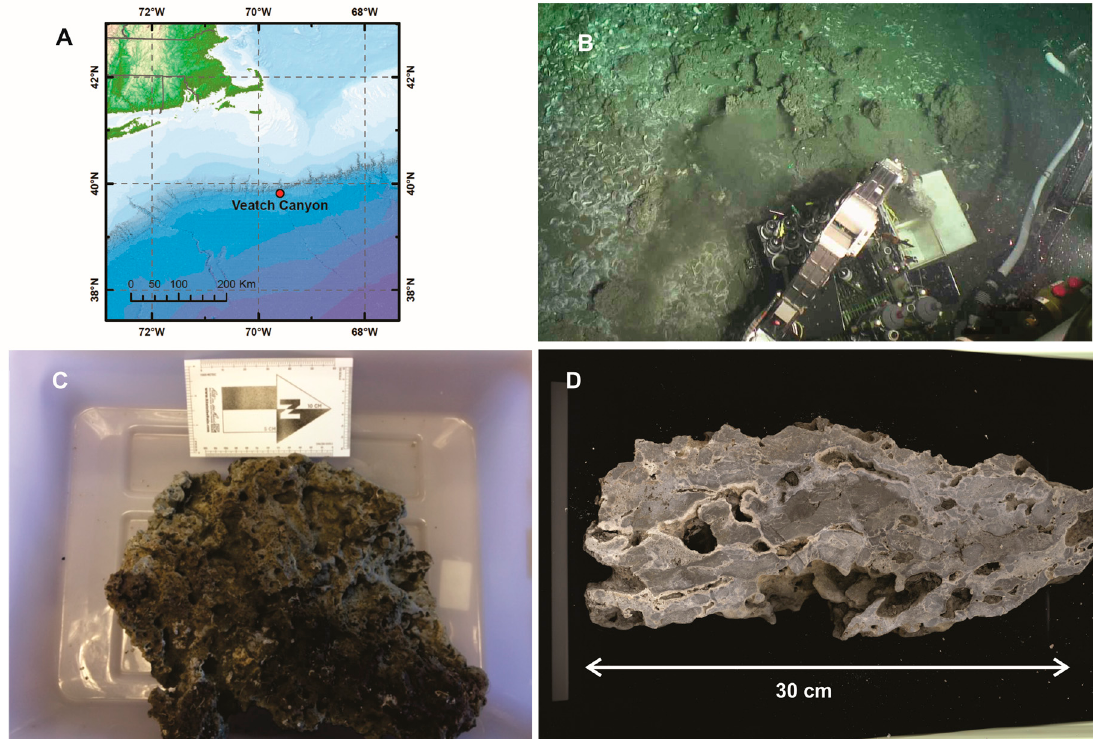
Figure 1. ( A ) Location of methane seeps at Veatch Canyon located (US Atlantic margin) determined using water-column backscatter data. ( B ) Collection of carbonate crust samples using robotic arm (1 Dive Site). ( C ) Sample: AD4835-BB4-S22; original location is preserved; time collected [GMT]: 18:50:51 August 6, 2016. ( D ) Picture of the sliced rock (30 cm width).